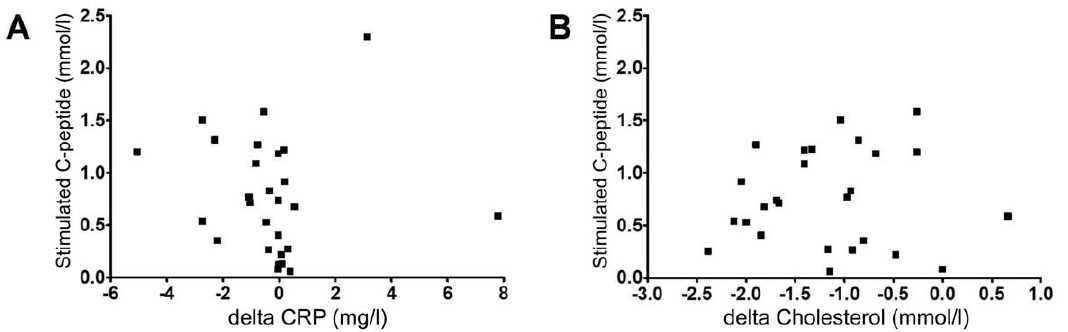
Figure 2. Correlation analysis of atorvastatin effects on cholesterol or CRP levels with C-peptide outcome. Of individual patients, the change of CRP concentrations ( a ) or total cholesterol concentrations ( b ) from baseline to 3 months of atorvastatin treatment (‘‘delta’’) were compared to stimulated C-peptide concentrations at 18 months (18 m).